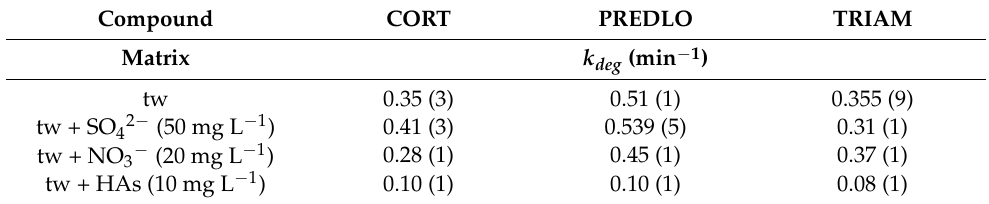
Table 4. Photodegradation constants ( k deg ) determined in tap water under simulated sunlight in the presence of inorganic salts and humic acids (HAs). Compound